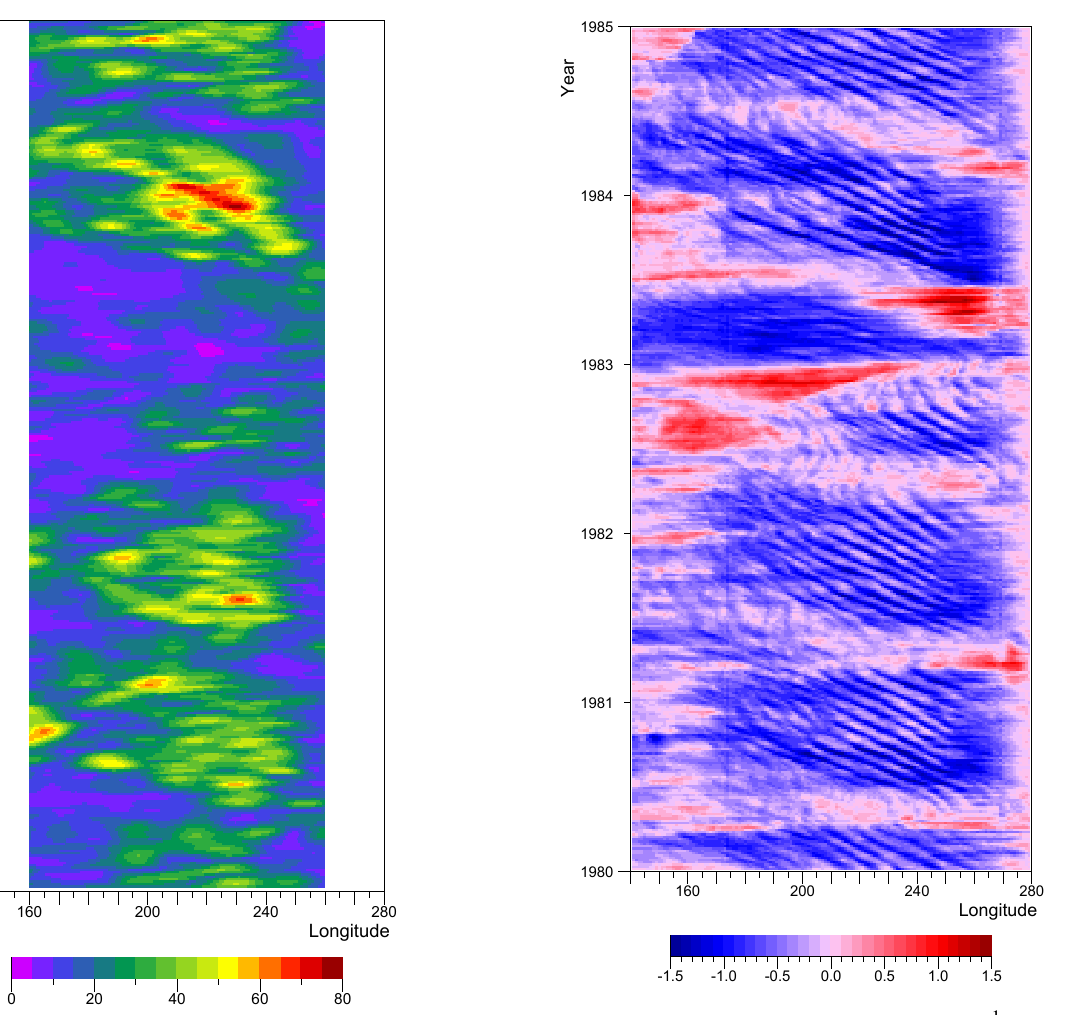
Figure 14. The rms northward transport variability V rms (defined in Eq. 6) along latitude 6 ◦ N. Units are m 2 s − 1 .